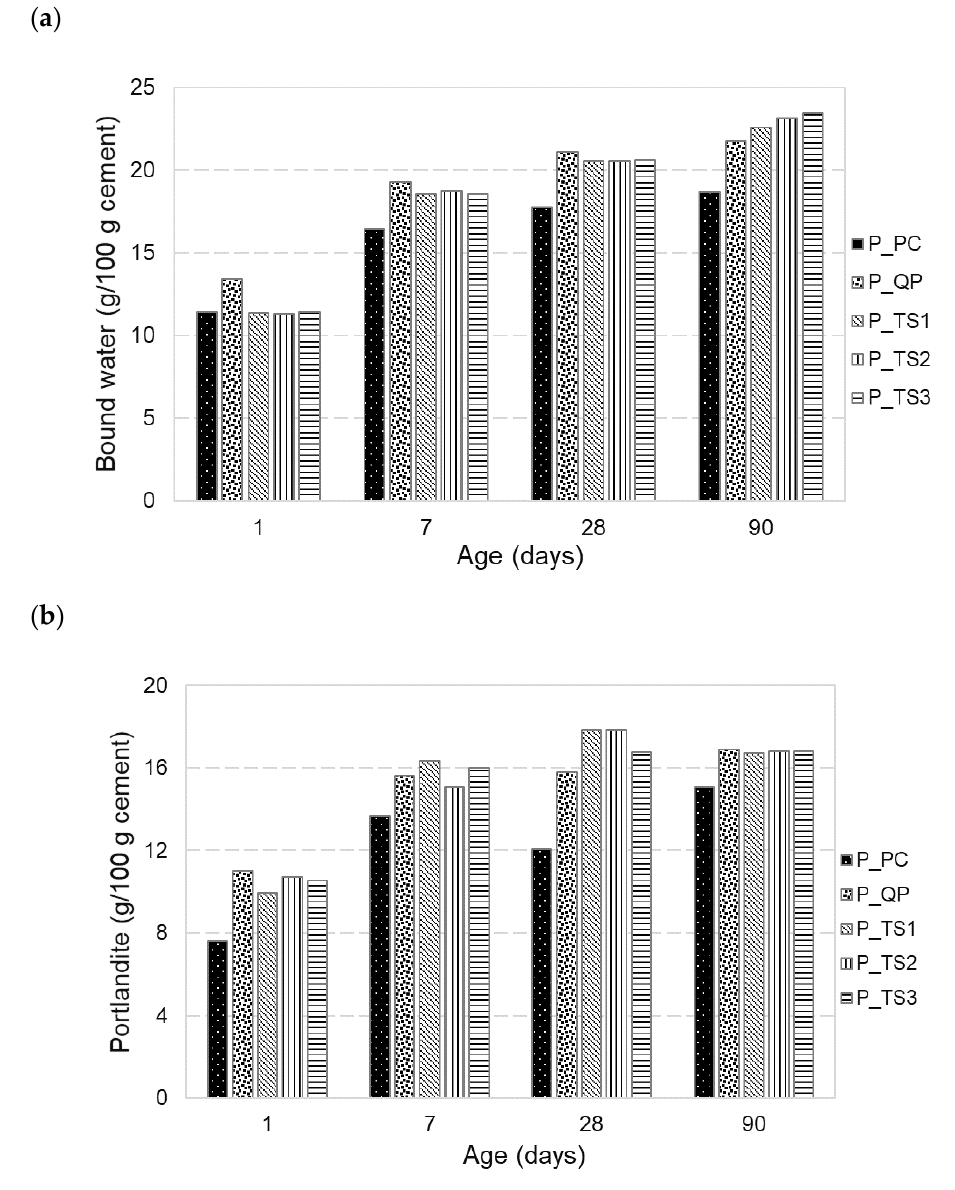
Figure 8. The bound water ( a ) and portlandite ( b ) contents of the paste mixtures up to the age of 90